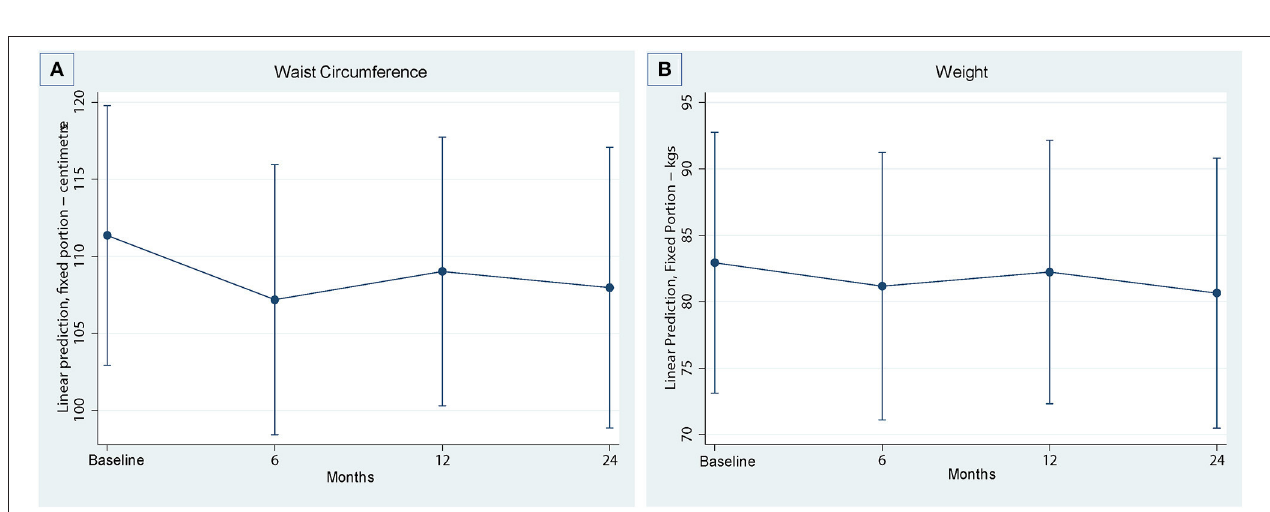
and there were some sessions on nutrition, similar to the NSW program (10). Our program may have benefited from